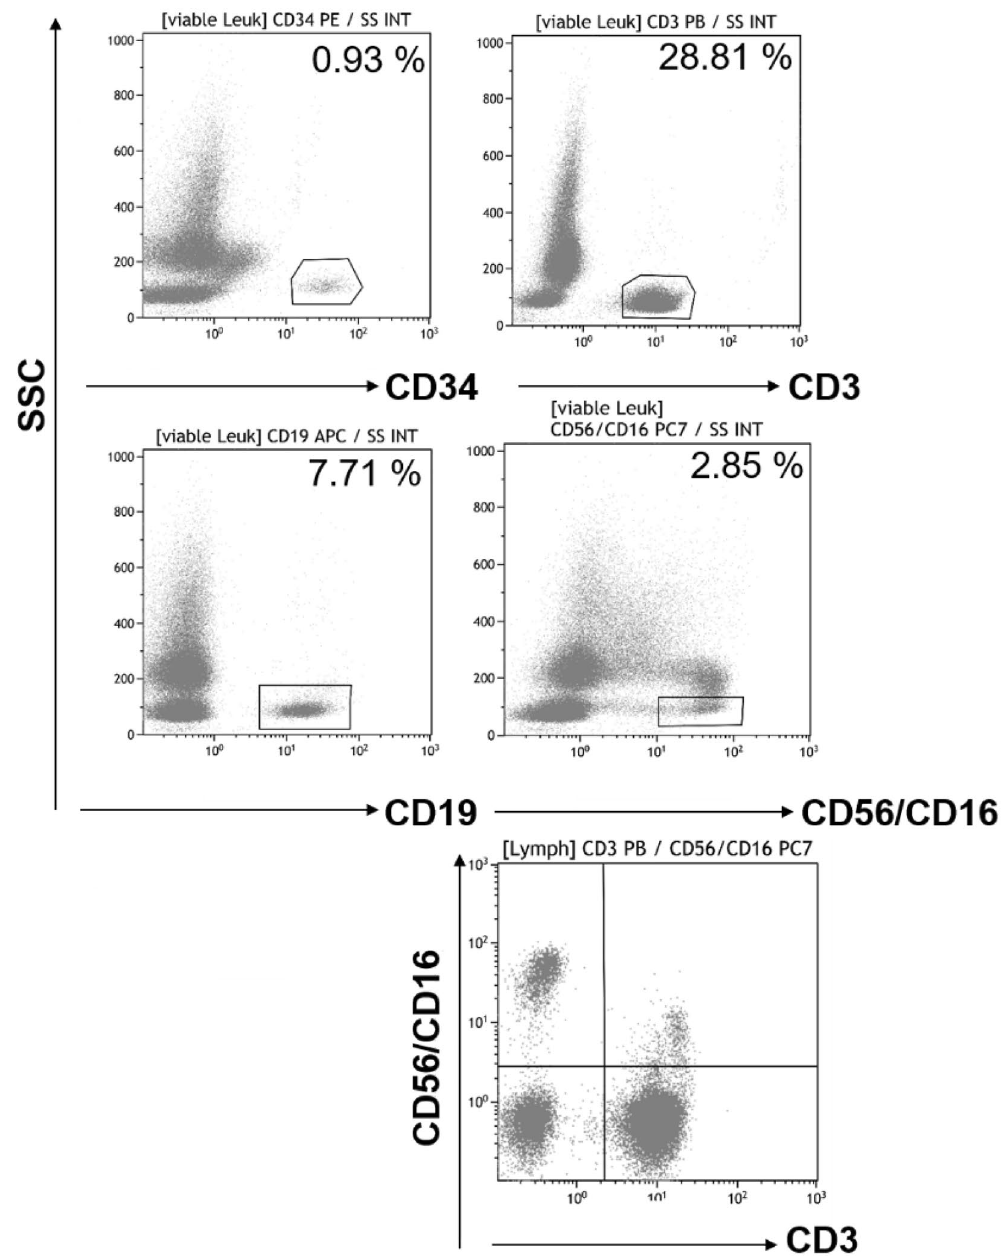
Figure 4. Expansion of the pre-formulated dried reagent panel: The template protocol (Supplemental Fig. S4) can be expanded for further parameter testing. For example, the addition of CD16 PC7 and CD56 PC7 fluorescence conjugates as drop-in to the dried pre-formulated tube enables the quality control for manufacturing of products enriched with natural killer cells (NK: CD45 + /CD56 + /CD16 + /CD3 − ) including natural killer T cells (NKT: CD45 + /CD56 + /CD16 + /CD3 + ) gated versus side scatter by excluding CD16 + neutrophils and CD16 + monocytes in the viable CD45 + leucocytes gate (Supplemental Fig. S4) for absolute counting. To distinguish between NK and NKT plotting CD3 PB versus CD16/56 PC7 gated on the lymphocyte population is crucial